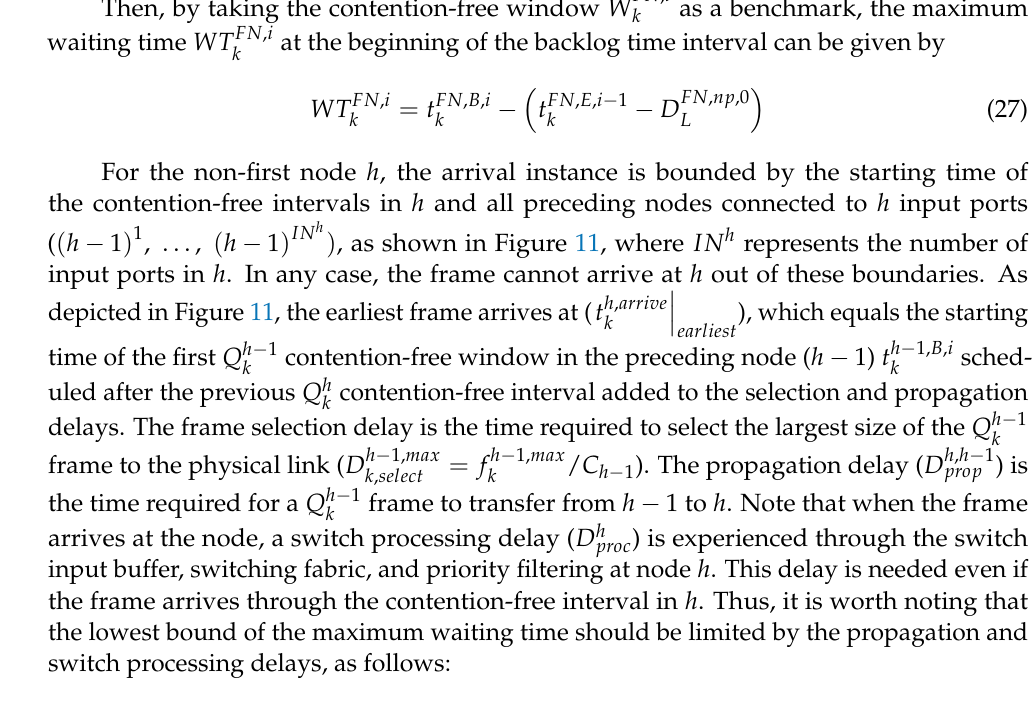
Figure 10. The maximum waiting time at the first node.